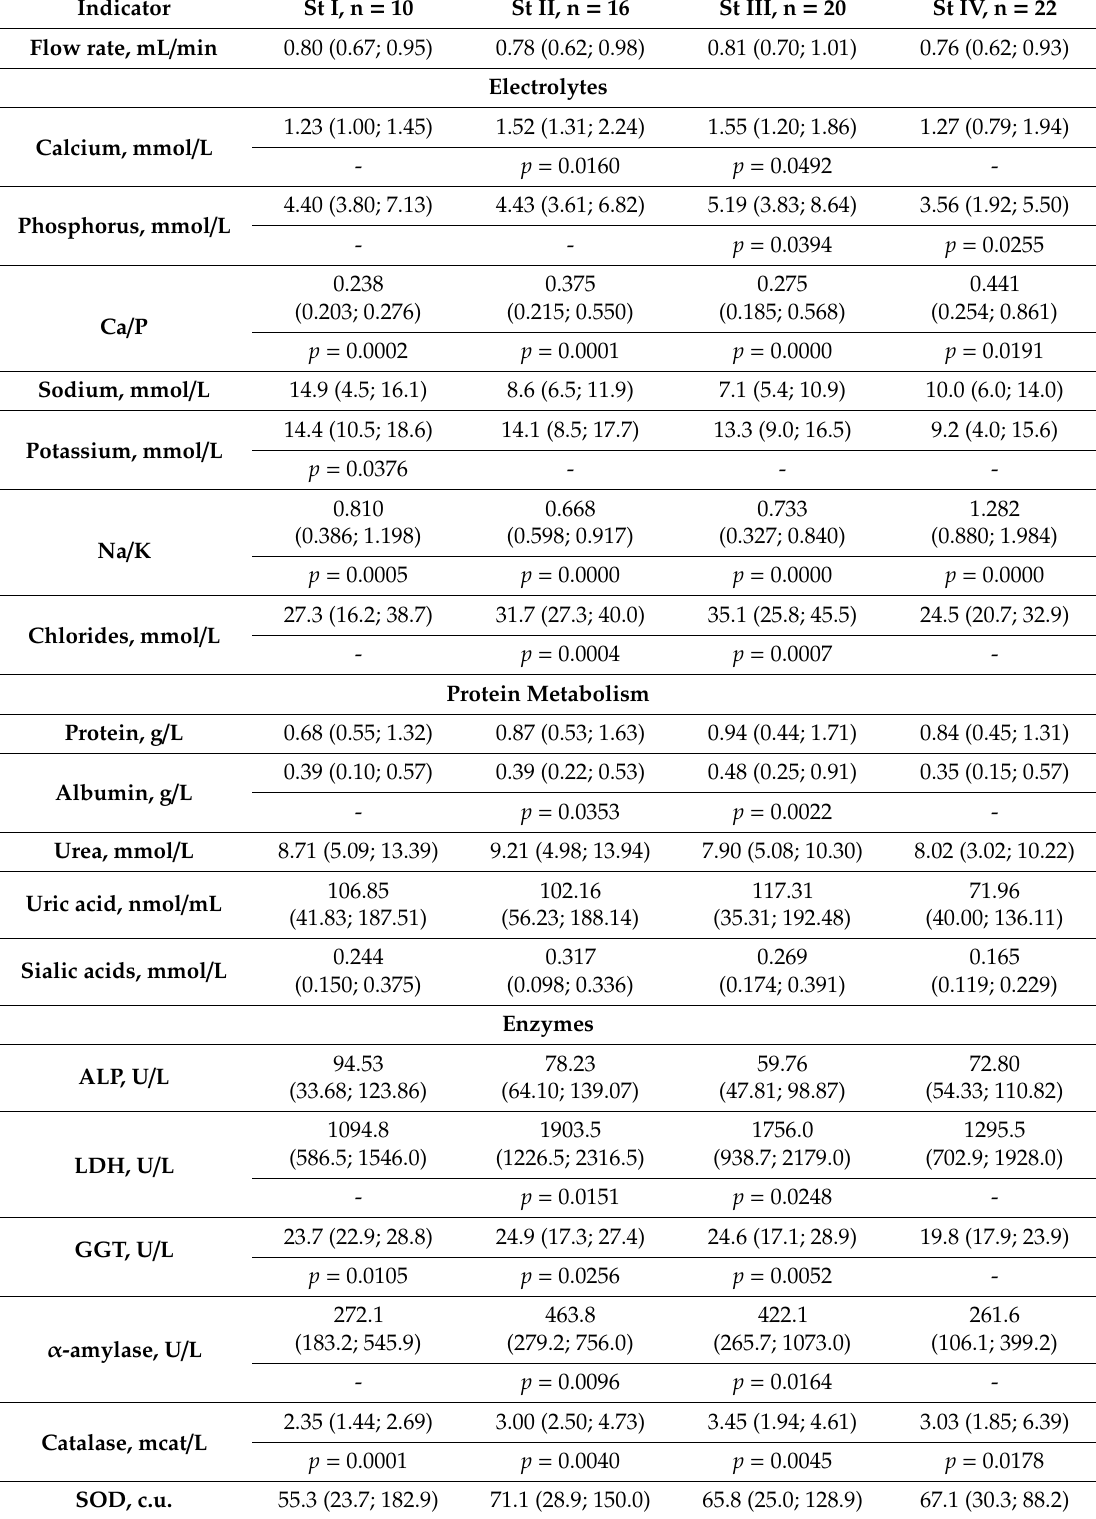
Table 2. Biochemical indicators of saliva in OSCC, depending on the stage